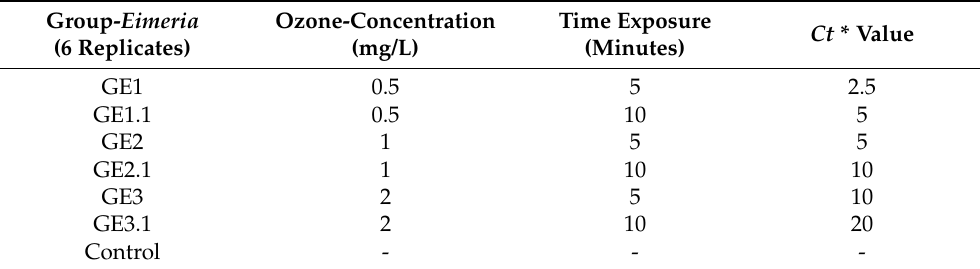
Table 1. In vitro tests for Eimeria oocysts using different ozone concentrations and time exposures (minutes) in the GE.